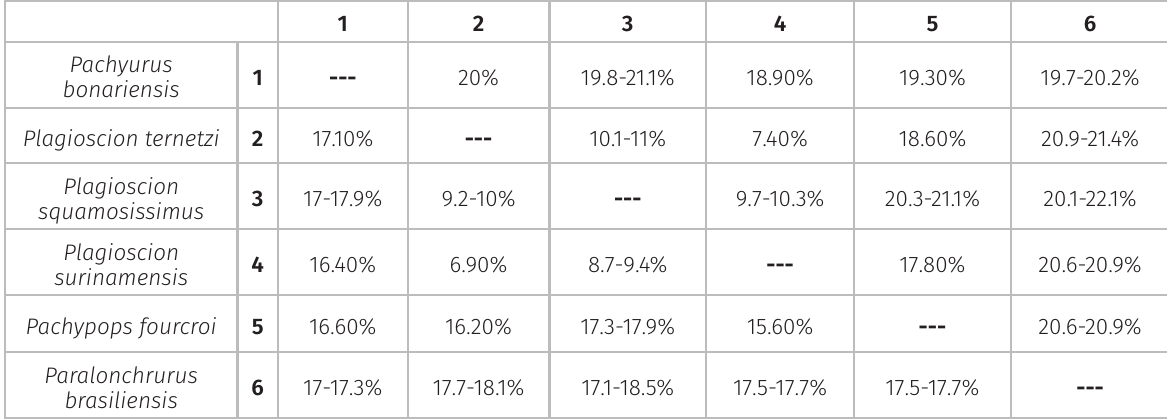
Table II. Interspecific genetic distances (in percent) for the COI gene among the analyzed